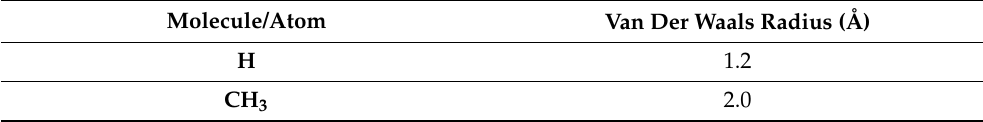
Table 2. Van der Waals radius of atomic H and CH 3